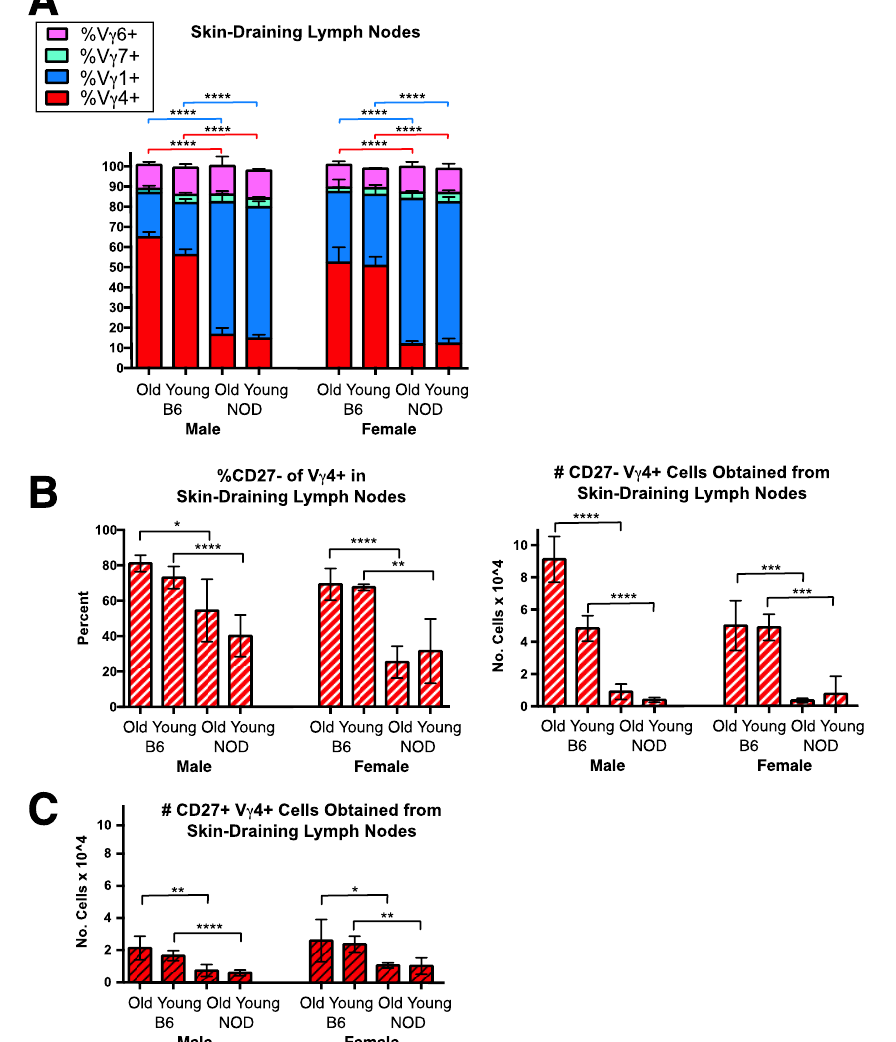
Figure 3. The γδ T cell repertoire in skin-draining lymph nodes of NOD and B6 mice. Results of samples from 4–12 individual mice were analyzed by flow cytometry for each group. ( A ). The mean percentage of each V γ -defined γδ T cell subset is shown for each group, as a fraction of all γδ TCR+ cells within skin-draining lymph nodes. ( B ). The mean percentage of V γ 4+ cells that failed to stain with CD27 is shown for each group as a fraction of all V γ 4+ cells (left), and the average number of CD27- V γ 4+ cells obtained per mouse from the 4 pooled skin-draining lymph nodes (right). ( C ). Average numbers of CD27+ V γ 4+ cells obtained from 4 pooled skin-draining lymph nodes. * p < 0.05, ** p < 0.01, *** p < 0.001, and **** p < 0.0001.